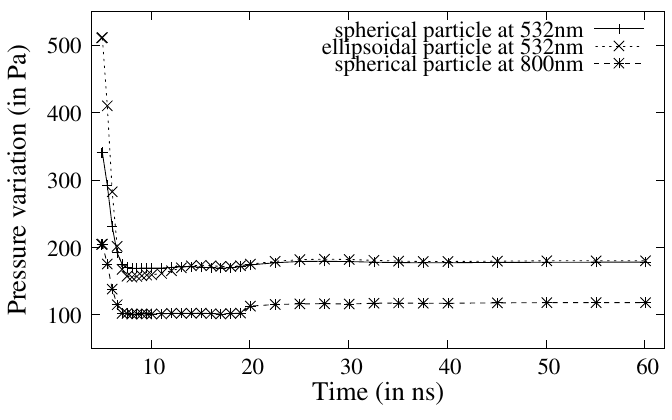
Figure 5. Evolution of the variation of pressure at the limit of the cell membrane as a function of time, along the y -axis for two nanoparticle shapes (spheroide of radius R = 50 nm illuminated at λ = 532 nm and λ = 800 nm, and an ellipsoide of semi-axis a = 100 nm, b = 50 nm illuminated at λ = 532